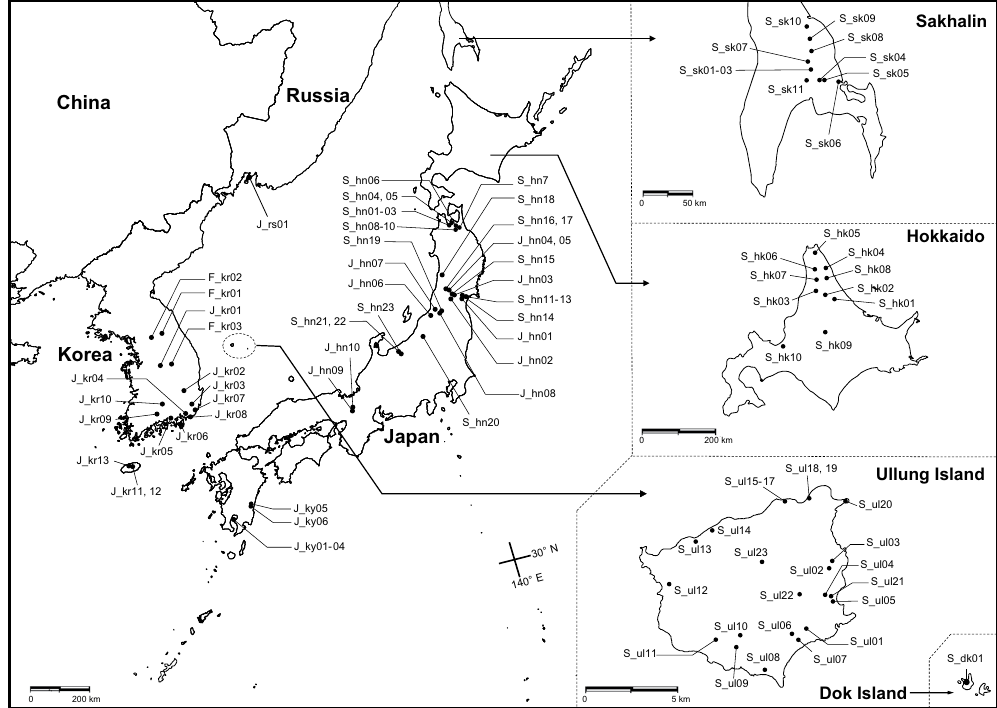
Figure 1. Localities of F. sachalinensis, F. japonica var. japonica , and F. forbesii collected from Korea, Japan, and Russia. Maps were modified from the GADM database of Global Administrative Areas v2.8 1 . The first letter in each accession name indicates the species collected, where F refers to F. forbesii , J to F. japonica var. japonica , and S to F. sachalinensis . The following lowercase two letters indicate the geographic locations of the populations; the Korean peninsula (kr), Honshu (hn), Hokkaido (hk), Kyushu (ky), Sakhalin (sk), Ullung Island (ul), and Dok Island (dk). 1 Global Administrative Areas (2012). GADM database of Global Administrative Areas, version 2.8.